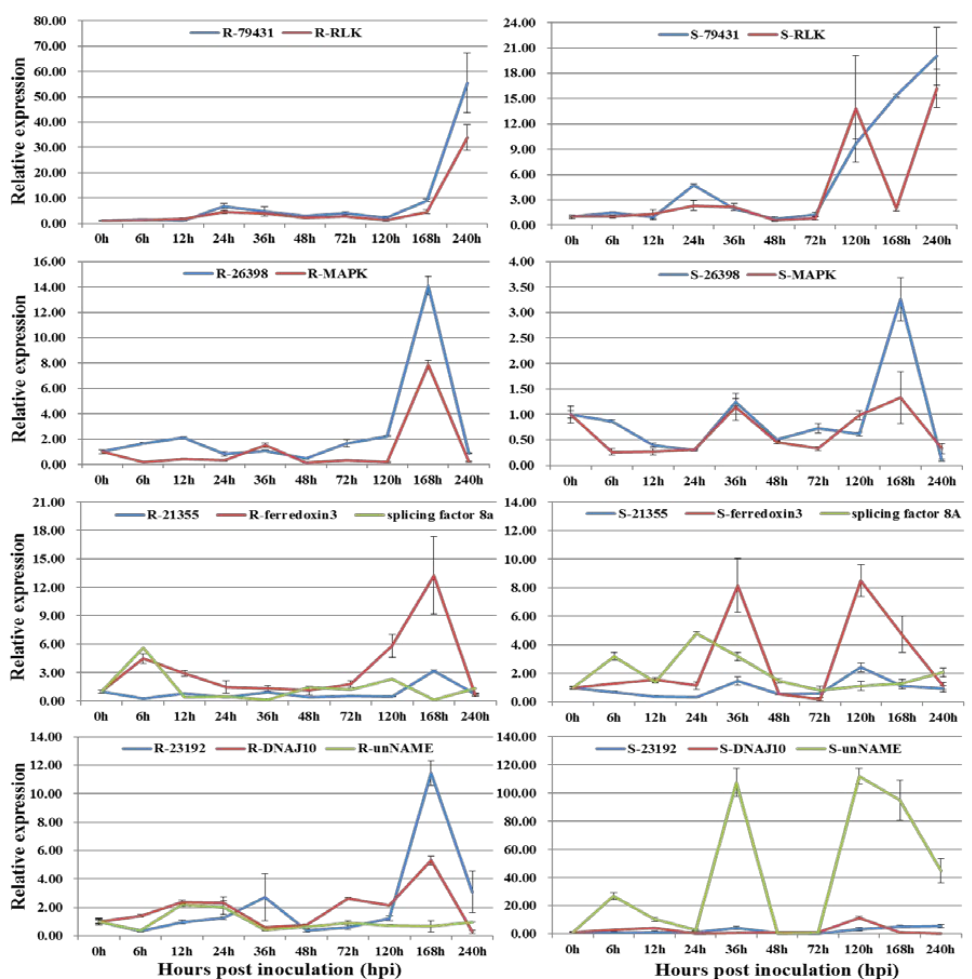
Figure 2. Expression patterns of lncRNAs and their nearby functional genes in N9134R and N9134S induced by powdery mildew infection at 0, 6, 12, 24, 36, 48, 72, 120, 168, 168, and 240 hpi. Gene expression levels were assessed by Q-PCR as aforementioned similarly. Blue lines represent the expression pattern of lncRNAs while red and green lines represent the flanked functional genes. These results showed that the lncRNAs are generally co-expressed with adjacent protein-coding genes, but not in all cases. It is noted that lncRNAs T10.65297, T4.45663, T10.79431, and T16.26398 are long intron ncRNAs, while T16.1187, T10.12768, T13.19448, T13.23192, and T16.21355 belong to long intergenic ncRNAs. The long intron ncRNAs (linncRNAs) seem to have closer co-expression relationships with their nearby functional genes. Taking the distance between lincRNAs with their adjacent functional genes into consideration, we noted that the distance from lincRNA T13.19448 to TraesCS4D01G172200 is 98,620 bp (r = 0.555), from T16.1187 to TraesCS1B01G146800 is 28,814 bp, and from T10.12768 to TraesCS1B01G243100 is 6,625 bp. Thus, the strength of correlation of expression maybe increased as the distance decreased. This hints that two types of lncRNAs both play regulatory roles, in both positive and negative ways. However, the degree of regulation via lincRNA was influenced by the distance. 3.3. Co-Expression of Long Non-Coding RNAs and Allele-Specific Genes